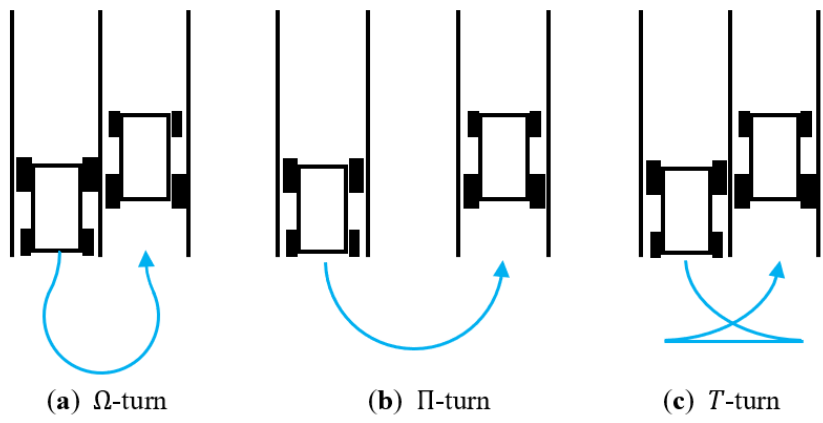
Figure 3. Three commonly used maneuvers in the headland turns. of the autonomous agricultural machinery, 𝑇𝑇 𝑐𝑐𝑐𝑐𝑐𝑐 𝑃𝑃 1 𝑃𝑃 2